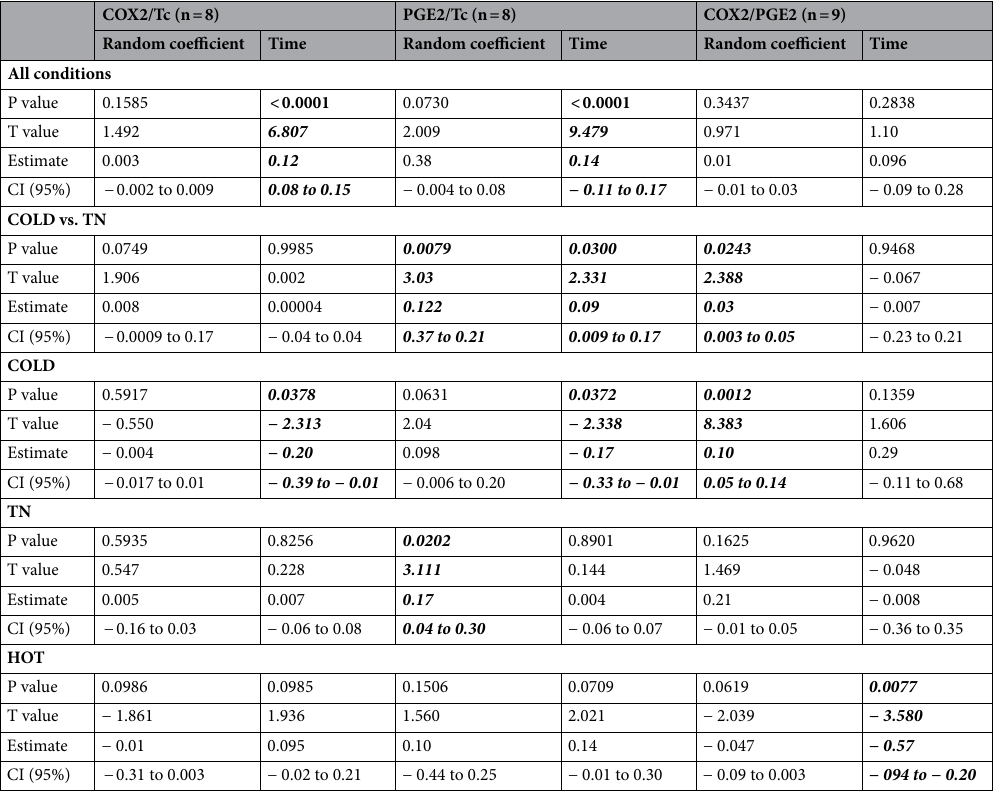
Table 3. Results from random coefficient model analysis. Results are presented as p values showing the significance of each relationship across all conditions (all data collapsed by condition and time), between COLD/TN (collapsed by condition and time) and within conditions. Time was included as a factor in all models. ES is not presented as this would involve crossover between statistical methods. Significant relationships and effects of time are highlighted in bold and